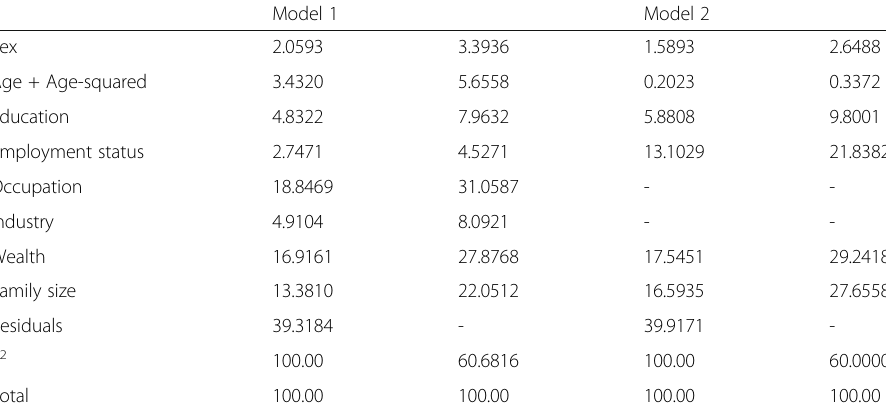
Table 3 Household income inequality decomposed through multivariate variables (%) Model